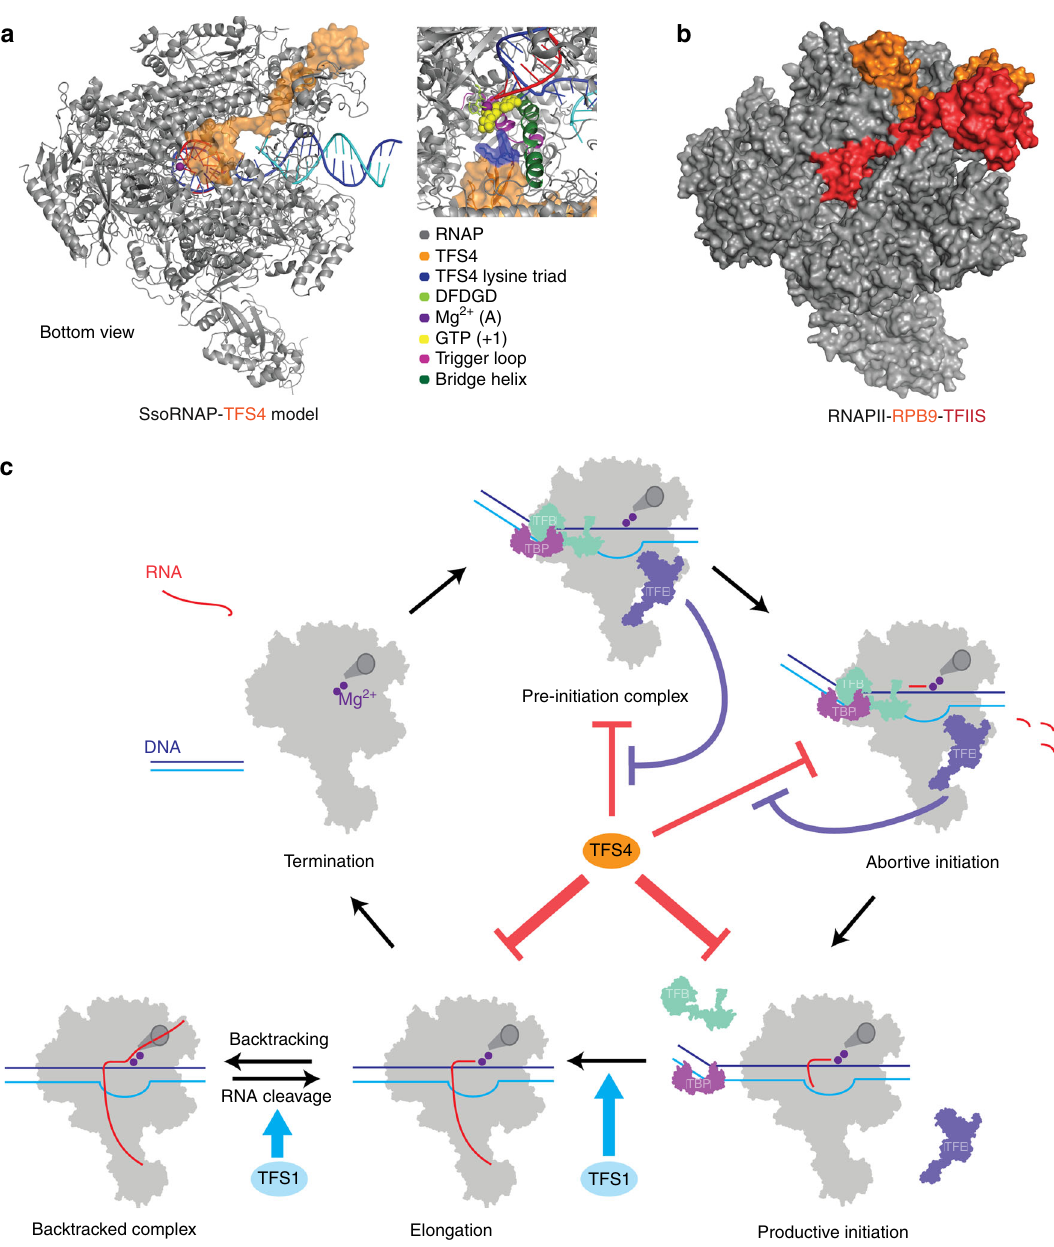
Fig. 7 Global regulation of SsoRNAP transcription cycle by TFS1 and TFS4. a Structural homology model of the Sso RNAP-TFS4 transcription elongation complex in which TFS4 is bound to RNAP akin to the A12 subunit to RNAPI. TFS4 is shown as surface representation in orange. b Surface representation of the yeast RNAPII – TFIIS complex highlighting RPB9 and TFIIS in orange and red, respectively. c A schematic representation of SsoRNAP transcription cycle. TFS1 stimulates productive transcription and rescues backtracked complexes by stimulating RNA cleavage by RNAP. In contrast, TFS4 inhibits transcription initiation by a two-fold mechanism. TFS4 (i) destabilises pre-initiation complexes (PICs) likely by an allosteric mechanism and (ii) interferes with catalysis by competing with substrate NTP binding. The basal factor TFE α / β stabilises the PIC and counteracts the inhibitory effect of TFS4, possibly by allosteric competition. During the elongation phase of transcription, TFS4 inhibits transcription by destabilising the RNAP – DNA – RNA complex and inhibiting